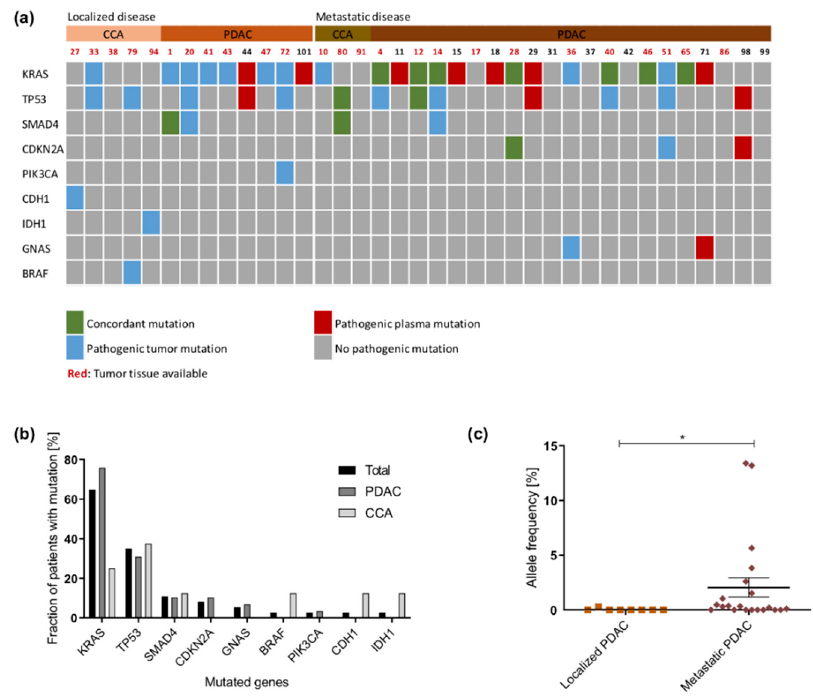
Figure 2. NGS analysis in plasma samples: ( a ) Oncoprint showing mutation occurrence of nine most frequently mutated genes across all patients. Patients are divided into those with localized and those with metastatic tumors. Concordant mutations are displayed in green, while mutations only detected in tissue or plasma are displayed in blue or red, respectively. ( b ) Distribution of mutations across the plasma samples. ( c ) KRAS allele frequency in plasma samples. Samples from CCA patients were excluded, as no KRAS mutation was detected in the plasma samples from these patients. *: p < 0.05.